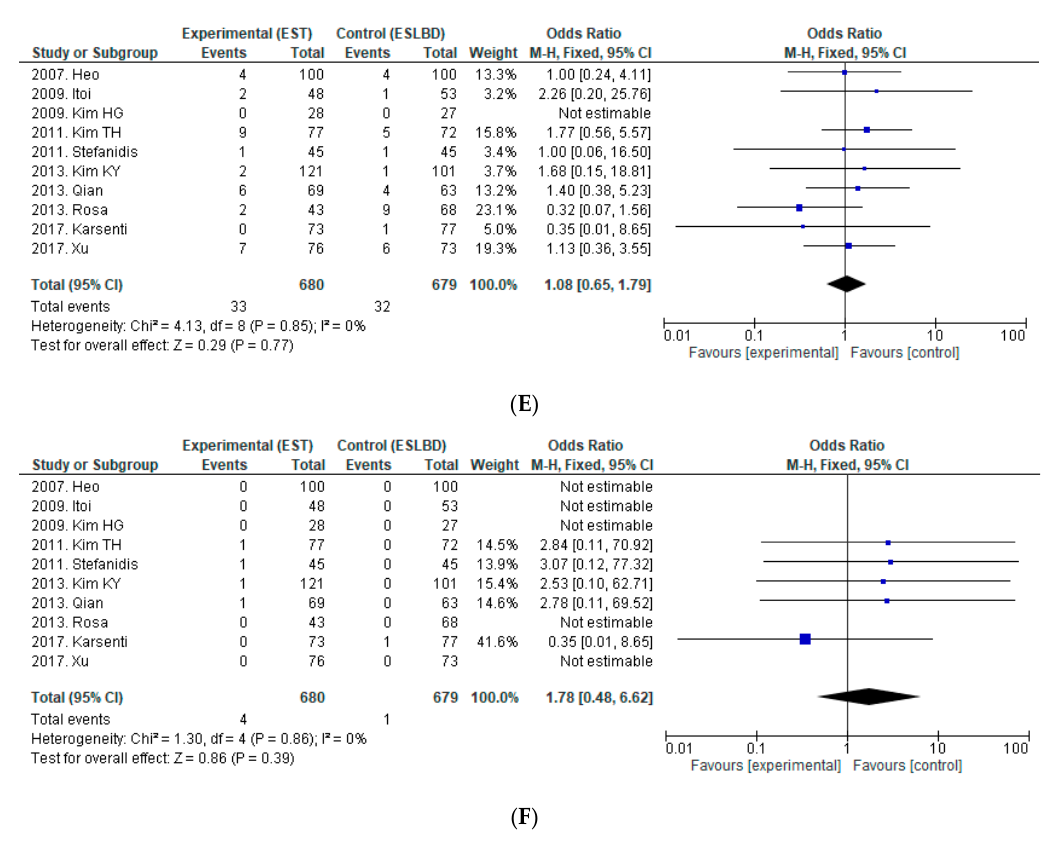
Figure 2. Forest plot of risk ratios and 95%CIs representing a comparison between EST and ESLBD. ( A ): Complete stone removal in the first endoscopic session. ( B ): Rate of mechanical lithotripsy. ( C ): Overall adverse events. ( D ): Bleeding. ( E ): PEP. ( F ): Perforation. CI, Confidence interval; EST, endoscopic sphincterotomy; ESLBD, endoscopic papillary large balloon dilation with endoscopic